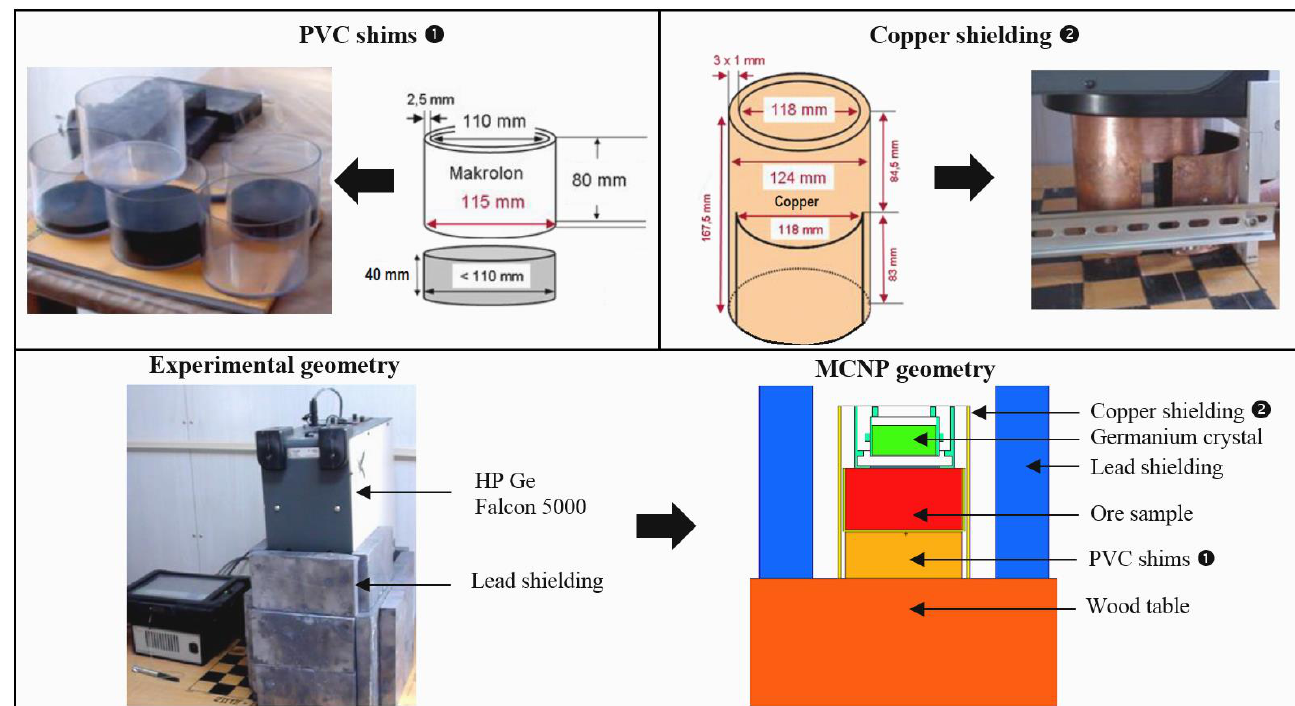
Fig. 3. Experimental and simulated geometry. On the upper left side, the PVC shims. On the upper right side, the copper shielding. At the bottom, the experimental geometry and the MCNP geometry.